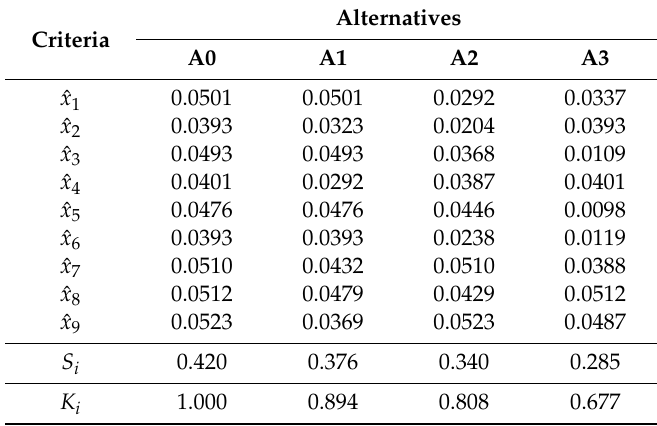
Table 8. Normalized-weighted criteria values ˆ x ij , the values of optimality function S i and the utility degree K i of each alternative (ARAS method).